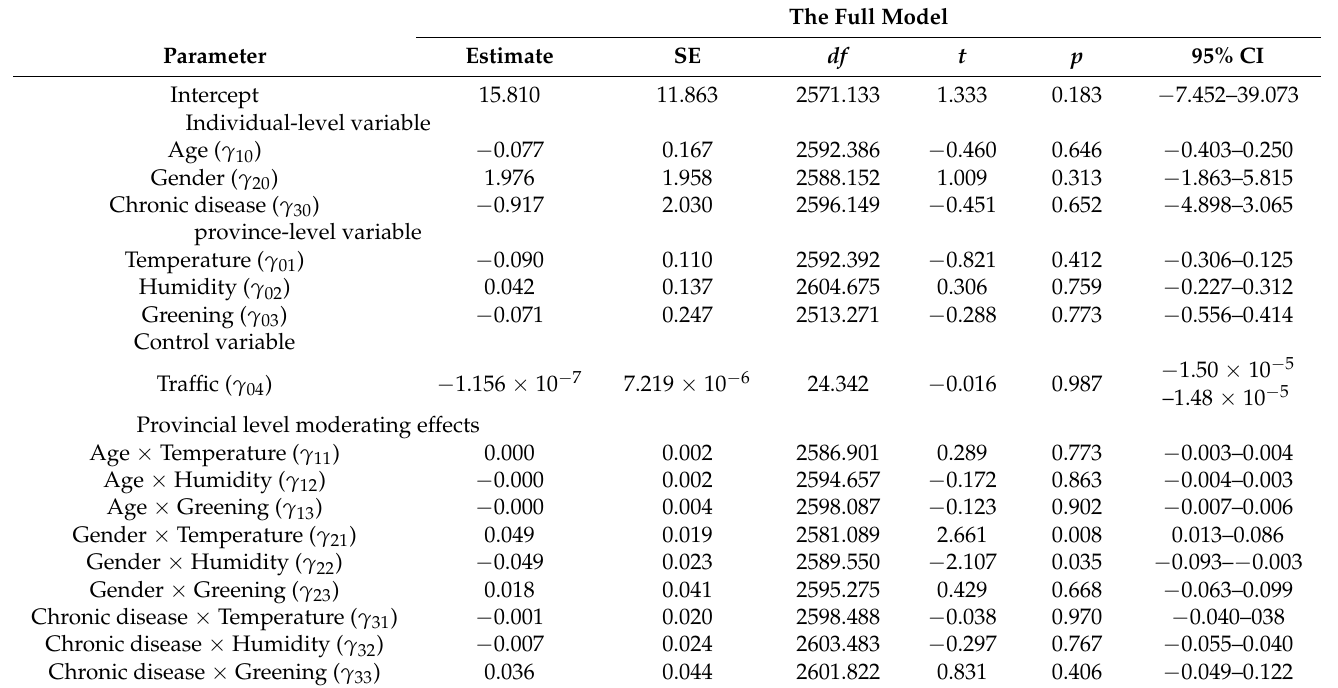
Table 5. The effects of individual-level and province-level variable in the full model. The Full